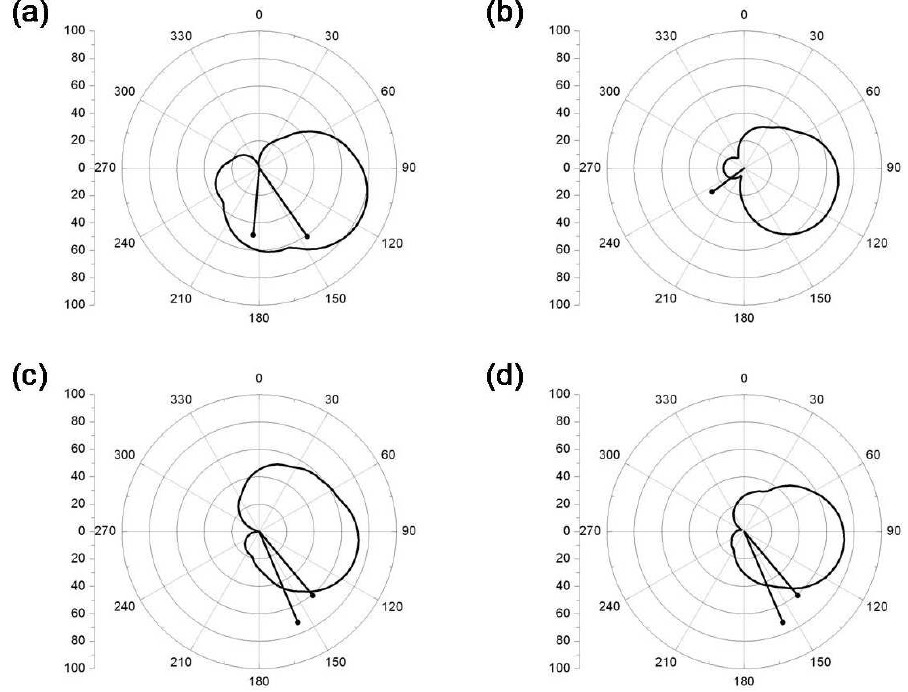
Fig. 15. Azimuthal plots showing the observed phase speeds versus the propagation direction for the three nights of observations. The contours show the wind blocking regions computed using falling sphere wind measurements. (a) shows the two events on 27/28 January while (b) shows the event on 29/30 January. (c) and (d) show the band and small-scale (ripple) events observed on 30/31 January with blocking regions calculated at 13:00 UT and 21:00 UT, respectively.